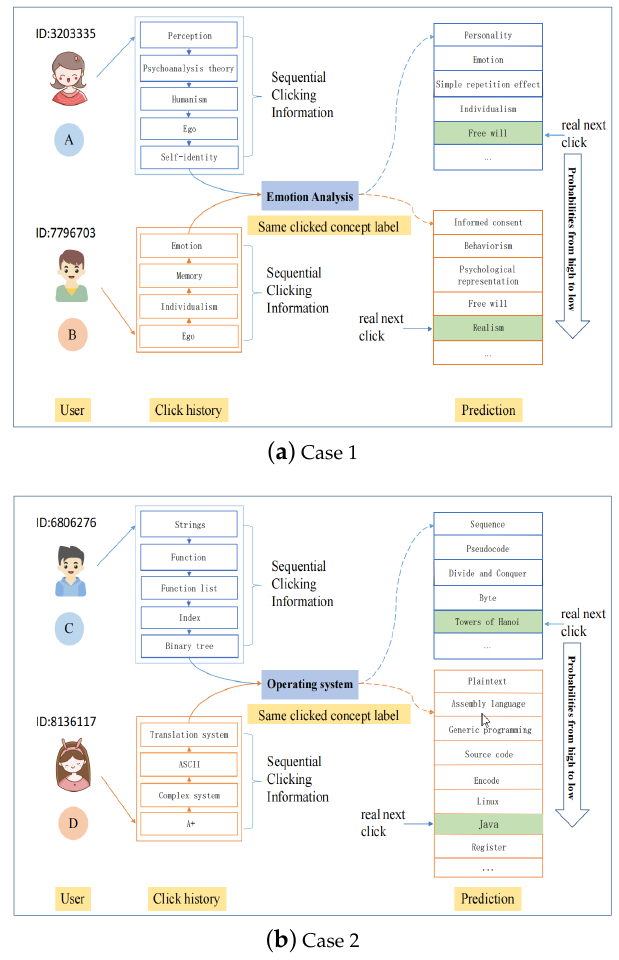
Figure 10. Diversity recommendation case with sequential clicked concepts information in a dynamic learning environment of XuetangX